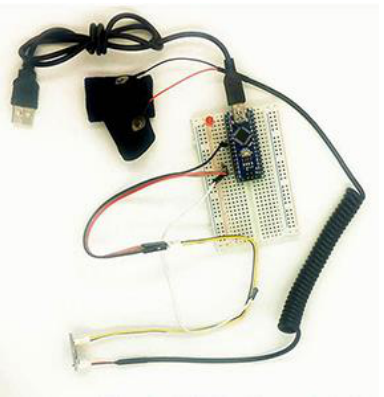
Figure 3. GSR skin electrical kit.